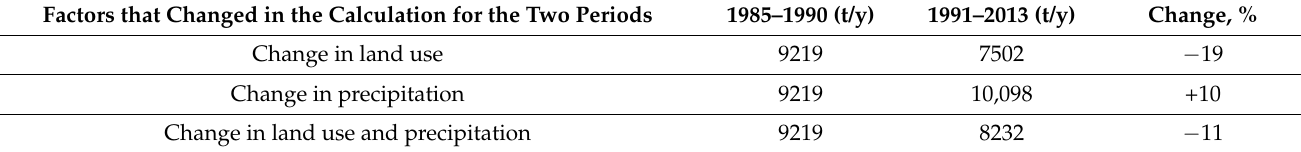
Table 8. Changes of sediment yield reaching the Sterlya River from the basin modeled by SEA/Balance, depend on changes in precipitation intensity and land